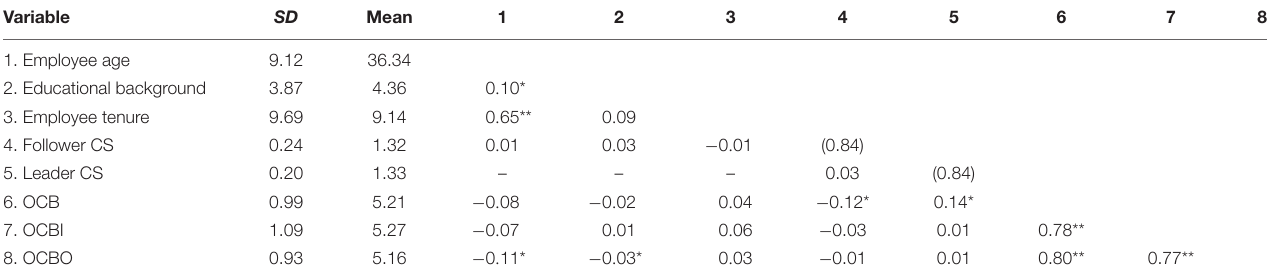
TABLE 1 | Means, standard deviations, and correlations among variables.